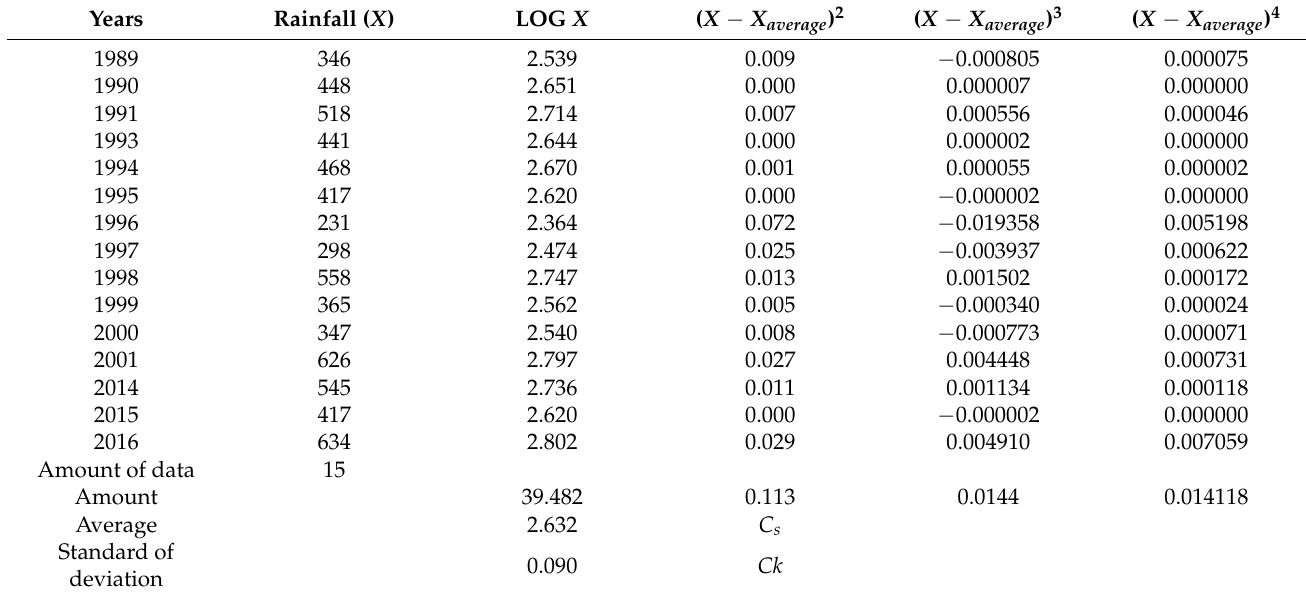
Table 1. Maximum rainfall data analysis